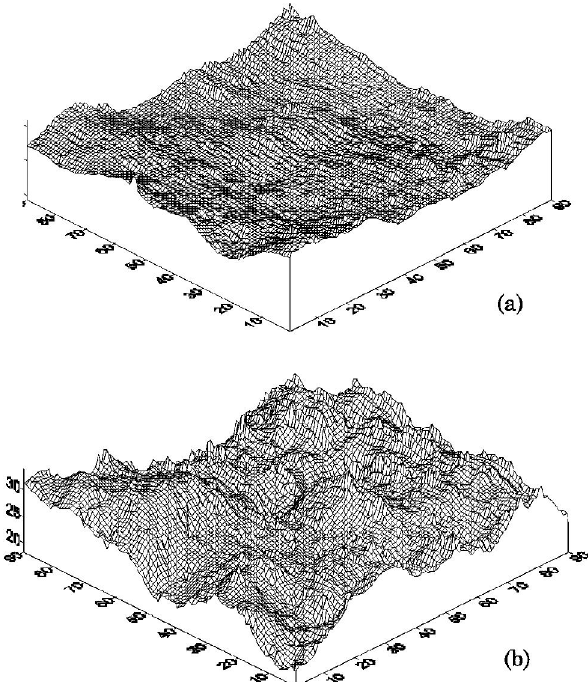
Figure 2. Three-dimensional representation of the soil profile before (a) and after tillage (b), assessed by a laser profile meter (in